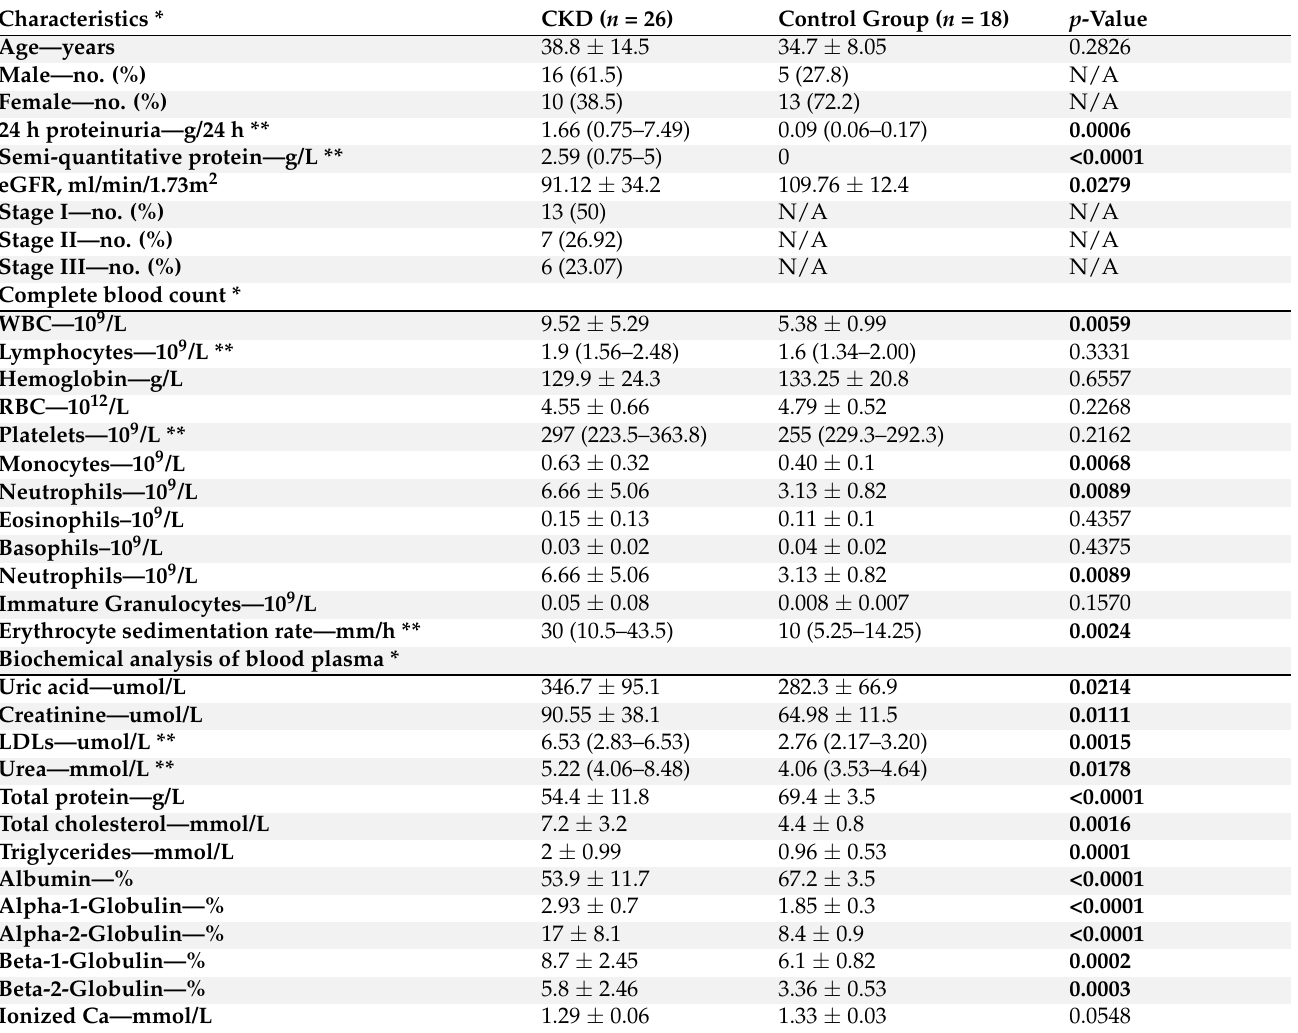
Table 1. Notable clinical characteristics of the study population.